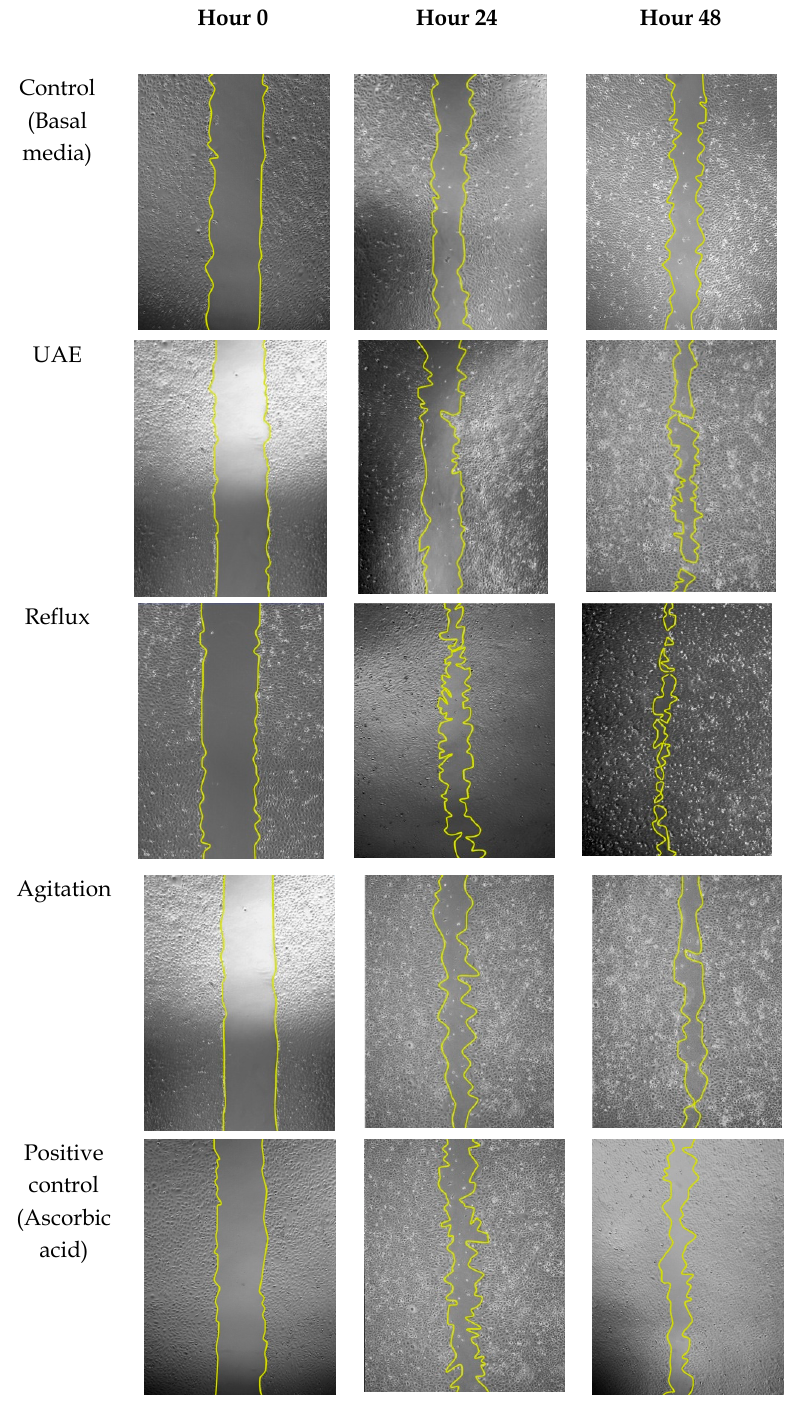
Figure 3. Effect of C. papaya extracts obtained from UAE, reflux, and agitation extraction techniques on the migration and proliferation rate of scratch HSF1184 cells. The migration rate was analyzed by using Image-J software. Results are expressed as the mean ± SEM of three independent experiments.